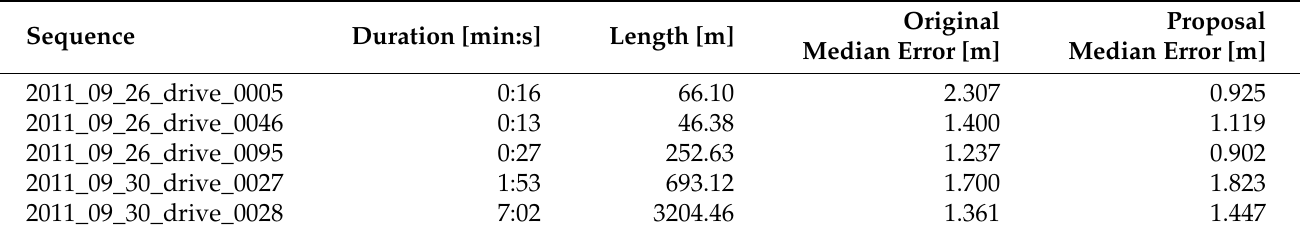
Table 2. Median results on KITTI sequences. Original is our previous work adapted with permission from ref. [28]. Copyright 2015 Copyright IEEE, without any building component, Proposal is this work.